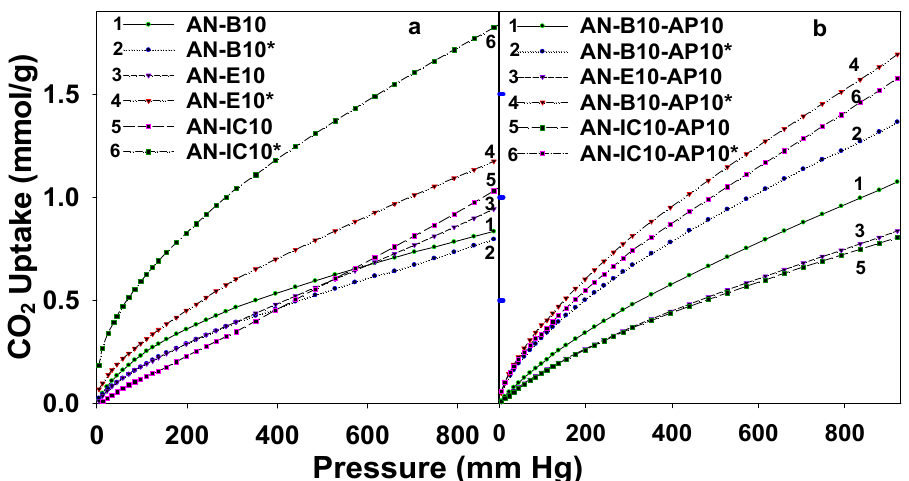
Figure 11. CO 2 adsorption profiles at 25 °C, measured on the extracted, and extracted and calcined a ) AN-Z10 and b ) AN-Z10-AP10 samples, where Z = B, E, or IC.